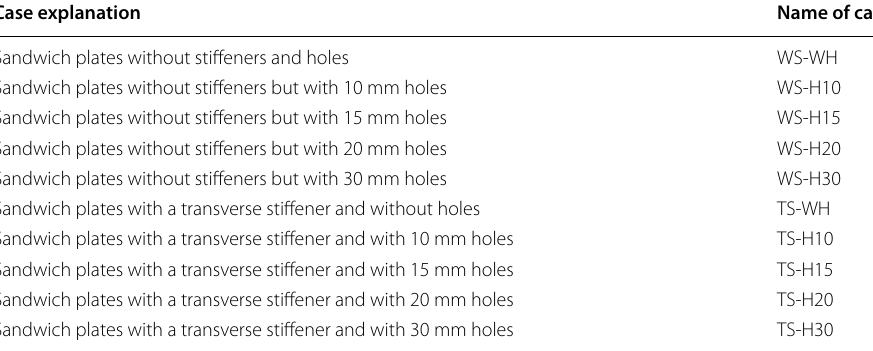
Table 3 Case details for the sandwich composite plates with holes in core